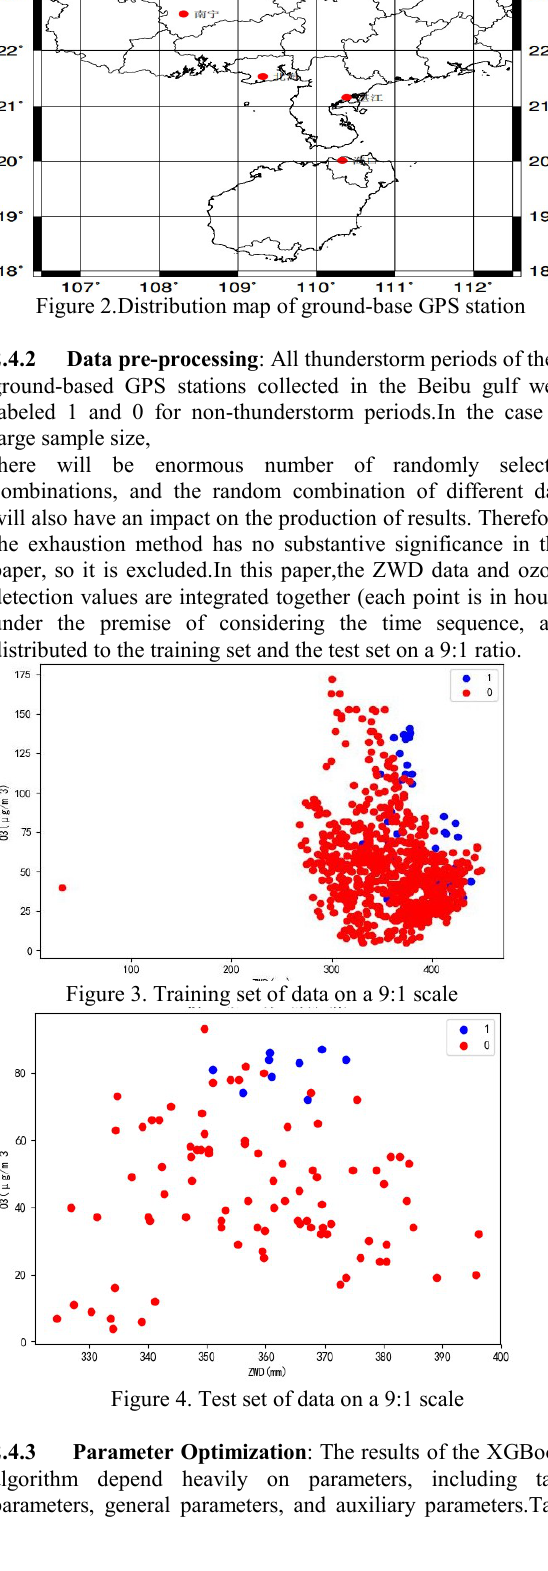
Figure 4. Test set of data on a 9:1 scale Figure 6.The result of the model of manual adjustment 2.4.3 Parameter Optimization : The results of the XGBoost algorithm depend heavily on parameters, including task parameters, general parameters, and auxiliary parameters.Task